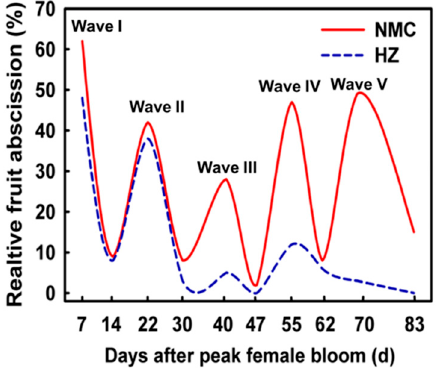
Figure 1. Fruit abscission pattern of litchi for normal-seeded cultivar ‘HZ’ (cv. Huaizhi) and aborted-seeded cultivar ‘NMC’ (cv. Nuomici).